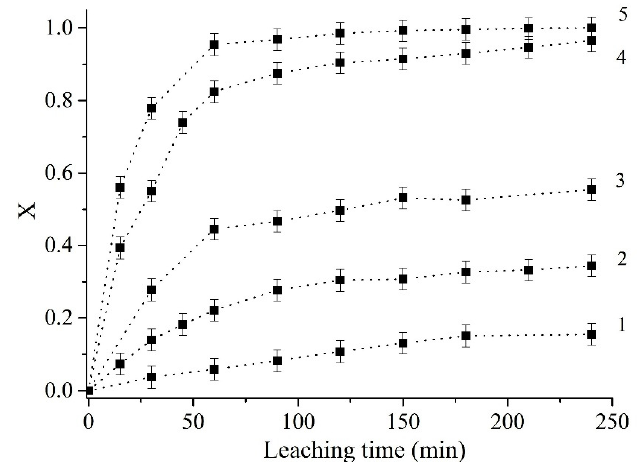
Figure 12. The kinetics of the leaching of ilmenite concentrate during processing in H 2 SO 4 (85 wt%) at temperatures of 100 ◦ C (1), 120 ◦ C (2), 140 ◦ C (3), 160 ◦ C (4), and 180 ◦ C (5).